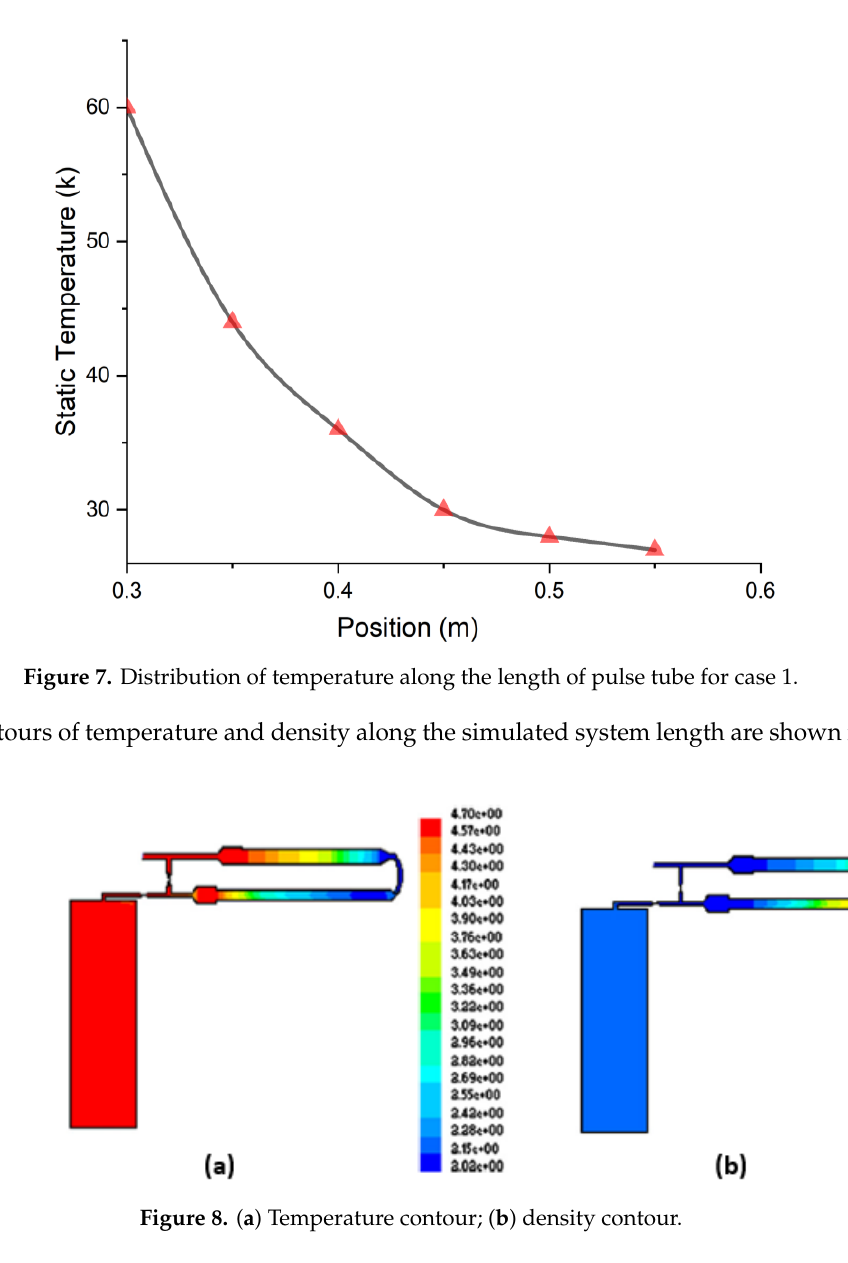
Figure 6. Effect of mass flow rates through pulse tube cross section for cases 1–3.